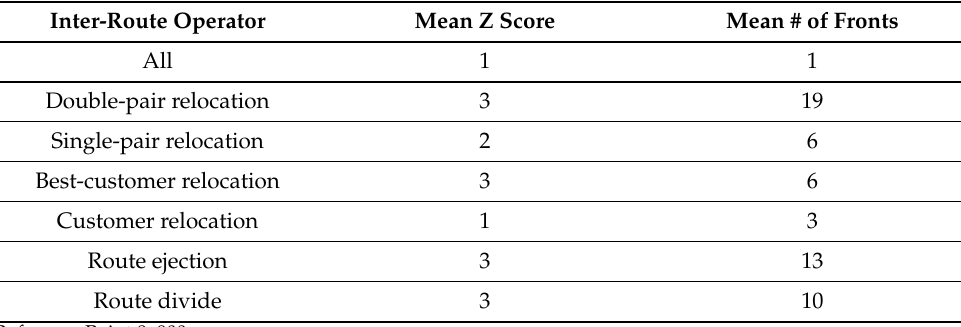
Table 10. Inter-route operation effects on solution quality of bar-n100-5 [29] Part